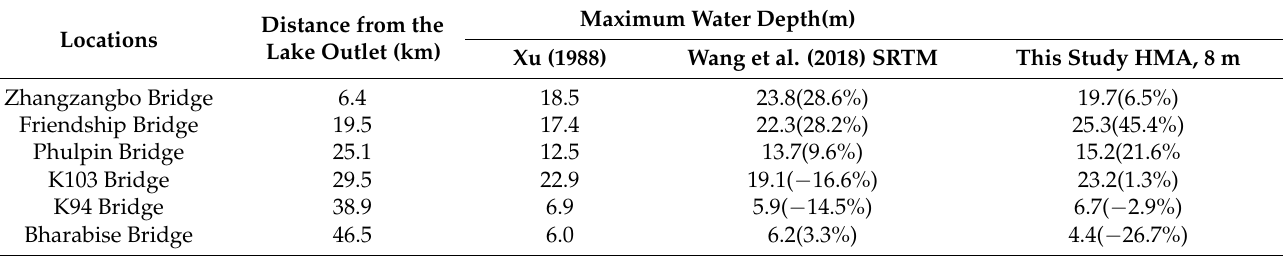
Table 6. Reconstructed water depth at selected locations compared with observations and previous